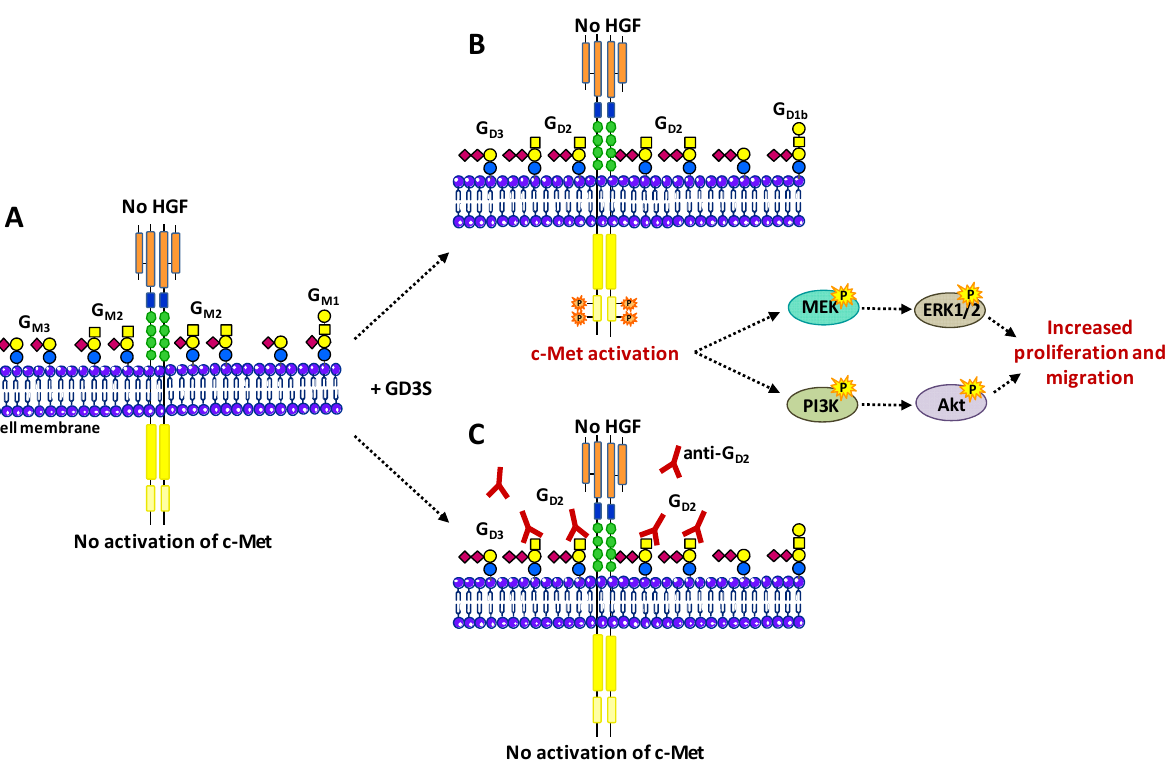
Figure 3. Activation of c-Met by G ganglioside. ( A ) MDA-MB-231 breast cancer cells D2 express mainly G and G . ( B ) The expression of the G synthase induces the M3 M2 D3 . This leads to the activation of accumlation of b- and c-series gangliosides, mainly G D2 c-Met in the absence of HGF and increases proliferation and migration through PI3K/Akt and MEK/Erk pathways. ( C ) Anti-G mAb used in competition assays inhibits c-Met D2 phosphorylation and cell proliferation